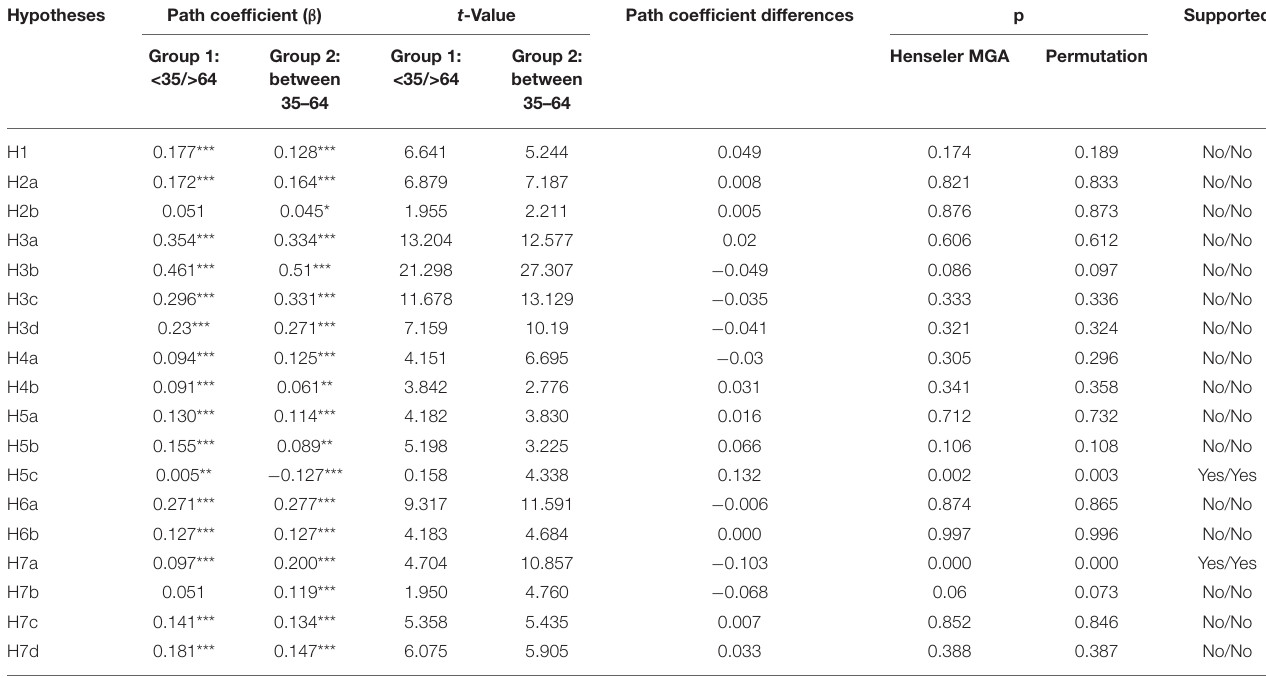
TABLE 6 | Assessment of group difference in age ( n = 3,011).